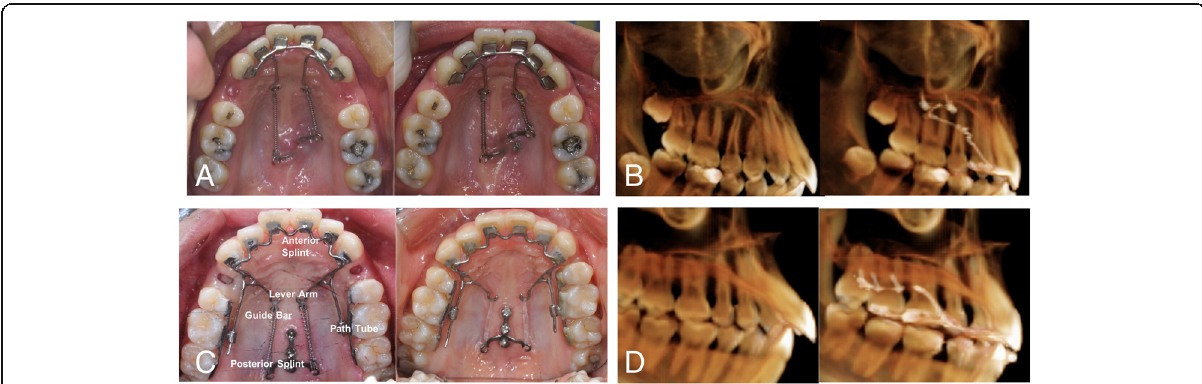
Fig. 1 Application of C-lingual retractor ( a and b , CLR) and antero-posterior lingual retractor ( c and d , APLR). Compared to CLRs, APLRs have a guide bar which connects the anterior segment and posterior segment through a path tube. CLR shows the clockwise tipping movement of the anterior segment, whereas APLR shows intrusive retraction with less torque loss from CBCT images